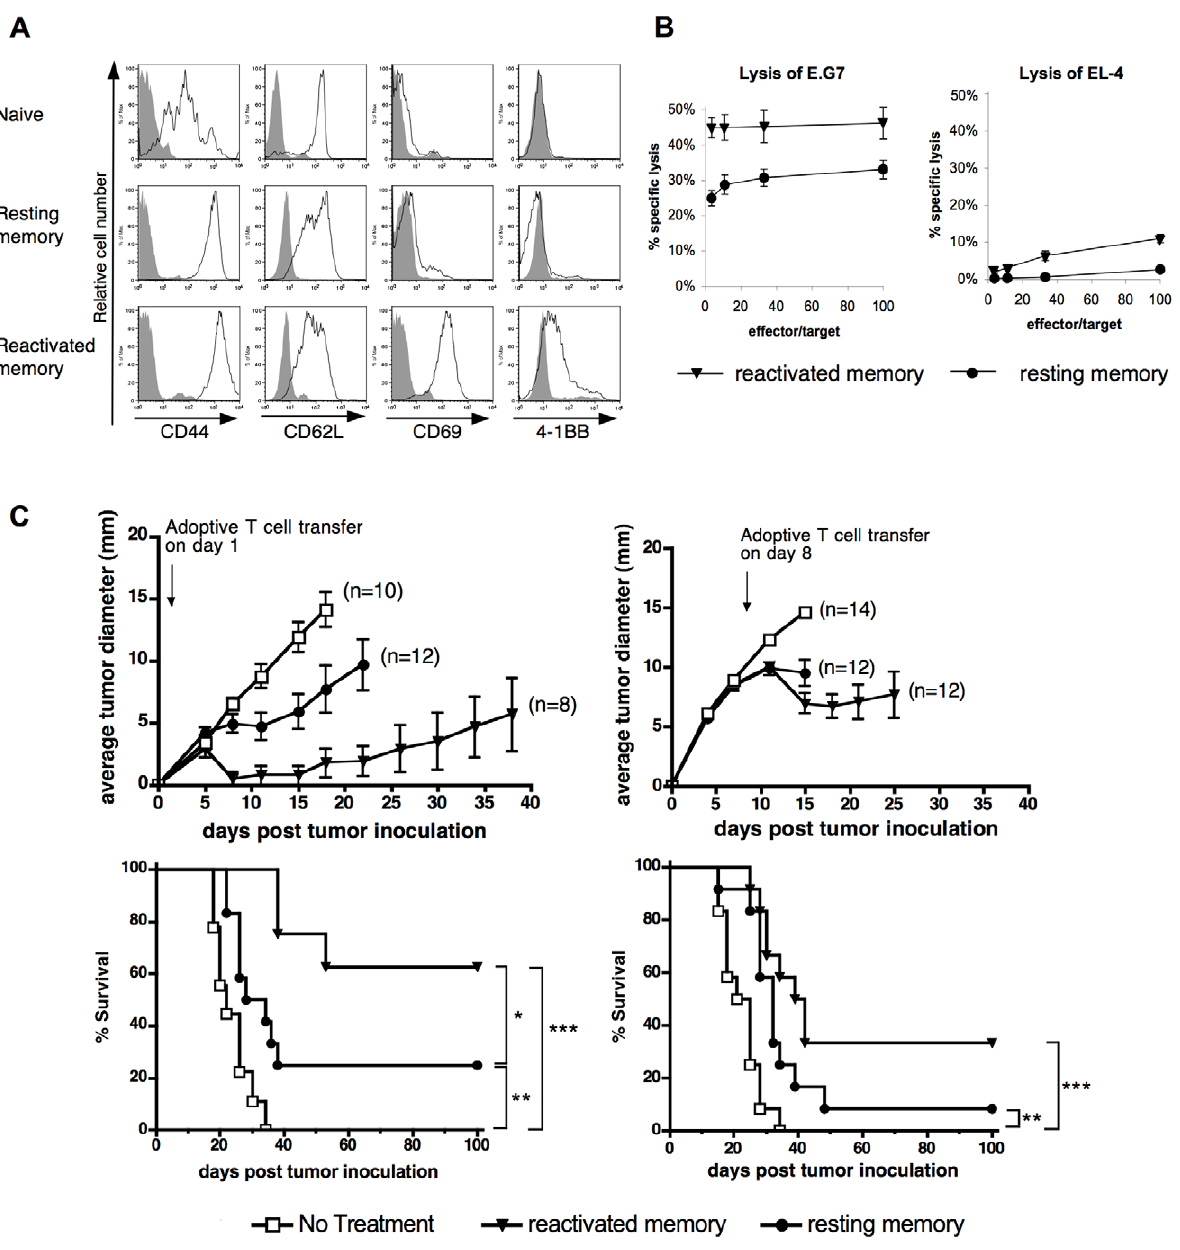
Figure 1. Superior anti-tumor activity of reactivated compared to resting memory T cells. (A) Phenotypes of naı¨ve, in vitro generated resting and reactivated OT-I memory cells. OT-I cells were surface stained for the expression of CD44, CD62L, CD69 and 4-1BB (open areas), overlaid on the background staining with isotype controls (shaded areas). Histograms were gated on the CD8 + population. (B) In vitro killing of E.G7 target cells by resting or reactivated memory OT-I cells. The cytotoxicity of resting and reactivated memory OT-I cells was tested on day 9 of culture, in a 4- hour Cr 51 release assay at the indicated effector to target ratios. Parental (ovalbumin negative) EL-4 cells were used as a negative control. (C) Adoptive immunotherapy of E.G7 tumor bearing animals with reactivated or resting memory OT-I cells. Mice were inoculated s.c. with E.G7 cells on day 0. One day (left panel) or eight days (right panel) later, tumor-bearing mice received 3 6 10 6 OT-I resting memory or reactivated memory cells i.v. or no cell transfer, as indicated. Average tumor growth, the number (n) of mice per group and survival of tumor bearing mice are shown. Tumor growth curves were discontinued at the time when the first animal in the group succumbed to the disease. Results are pooled from two independent experiments. Survival curves were analyzed by the LogRank test, with *P , 0.05, **P , 0.01 and ***P , 0.001